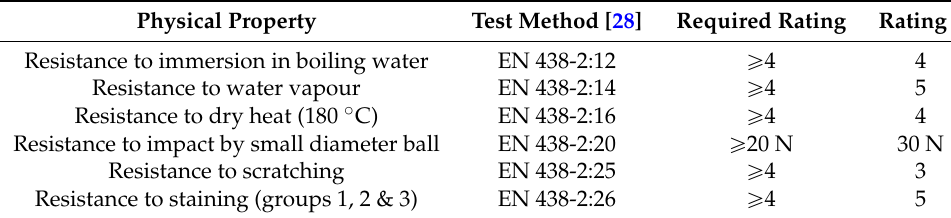
Table 1. Physical and surface quality properties of AS and SAS samples of 2.4% (IN) PHMB ‐ HPL.